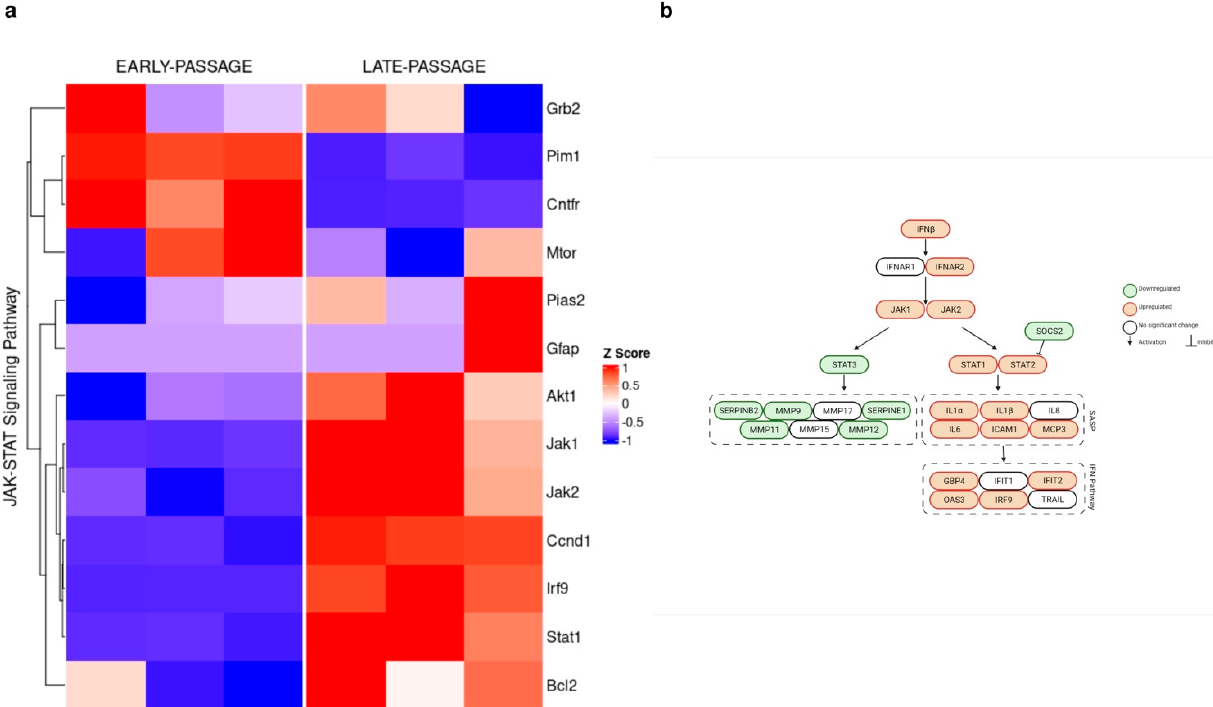
Table 1. Gene list related to cellular senescence/SASP and JAK–STAT signaling in the early and late passages of BMRs and mice.